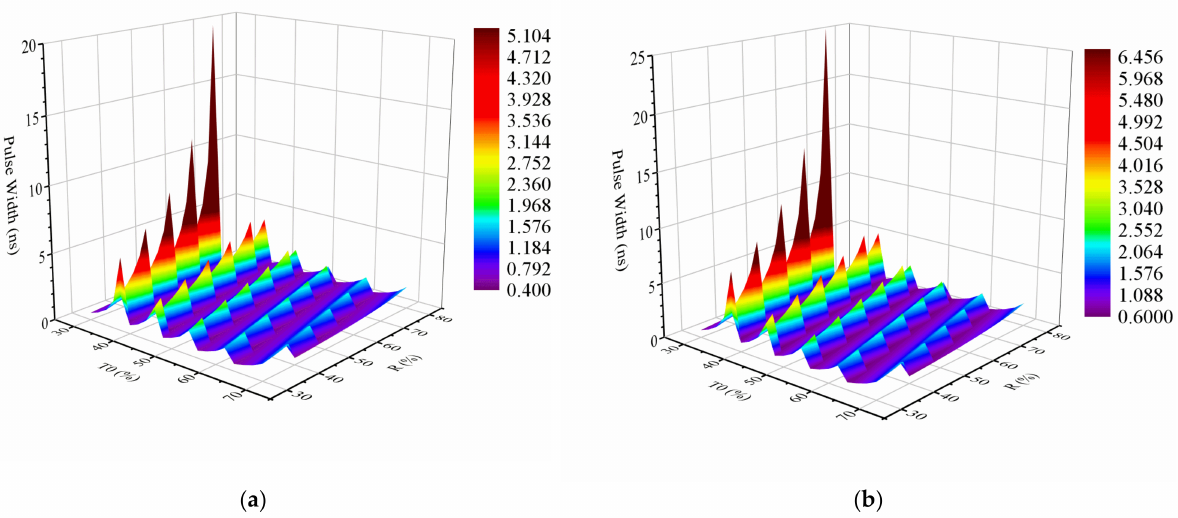
Figure 9. Pulse width change versus initial transmittance and reflectivity at different cavity lengths. ( a ) C L = 7 mm; ( b ) C L = 9 mm.